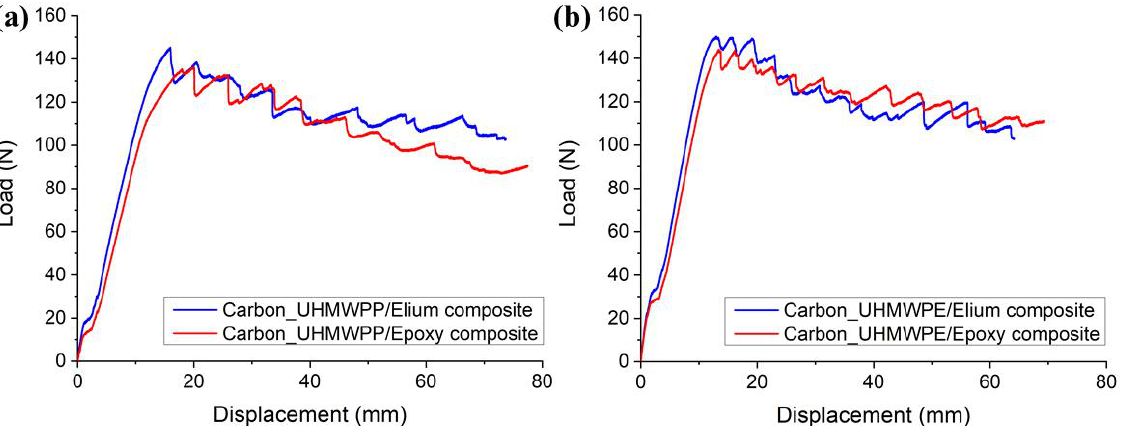
Figure 7. Load vs. displacement graphs for ( a ) Hybrid Carbon_UHMWPP ( b ) Hybrid Car- bon_UHMWPE composite configurations .